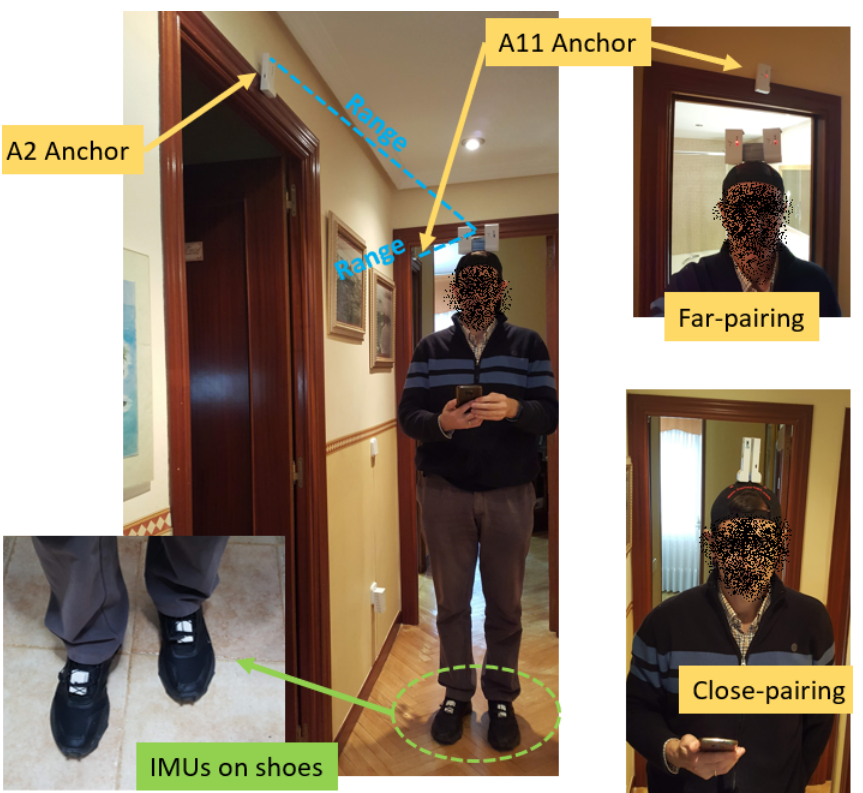
Figure 17. Apartment details, showing some examples of anchors locations, tags mounted on a cap on the actor’s head in both pairing configurations, and IMUs attached on